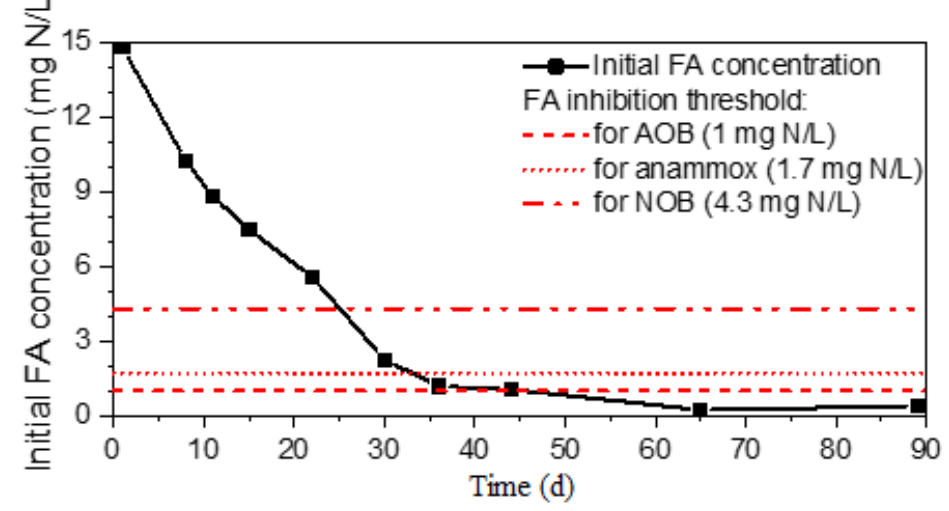
Figure 3. Initial FA concentration and FA thresholds for AOB [25], NOB [41] and AAOB [42].